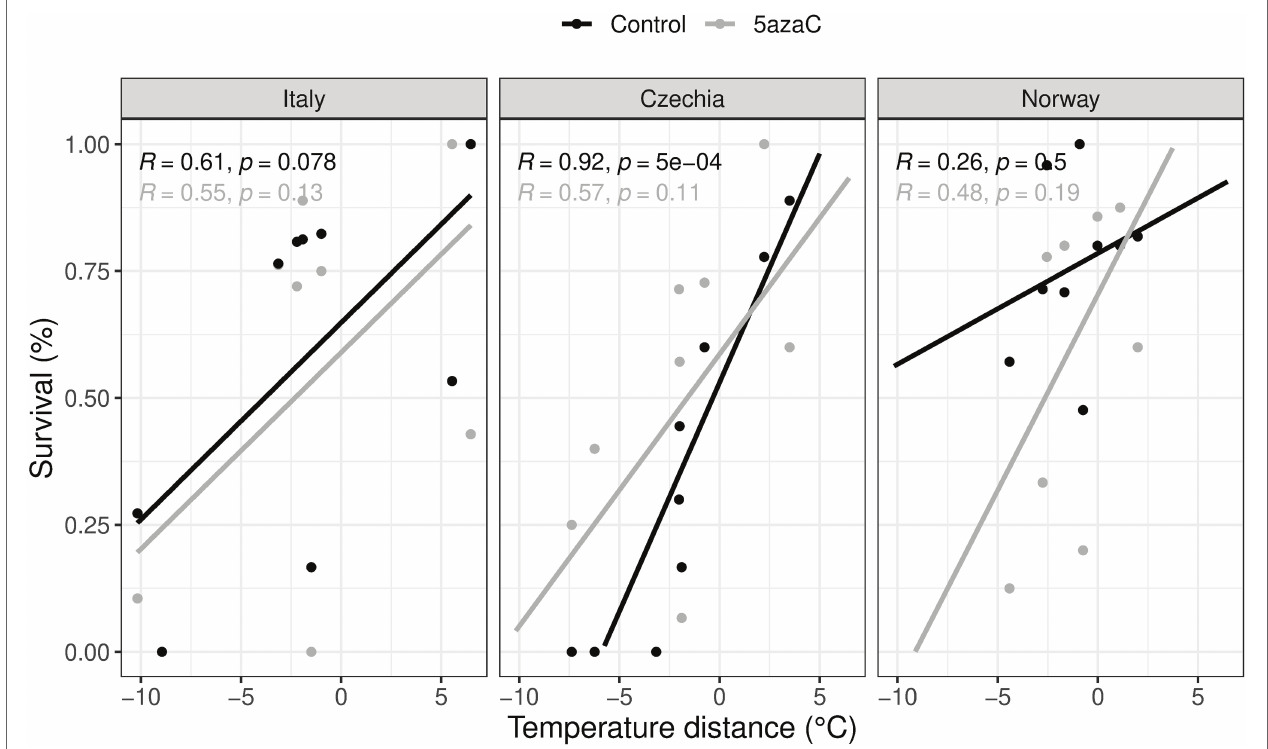
FIGURE 3 | Is adaptation to warm and/or cold conditions mediated by DNA methylation (Hypothesis 3)? Effects of country, temperature distance and 5-azaC on plant survival. Positive values represent shift to colder sites, negative values to warmer sites. Control: plants with natural DNA methylation, 5azaC: plants treated with 5-azaC. R: Pearson correlation, p : p